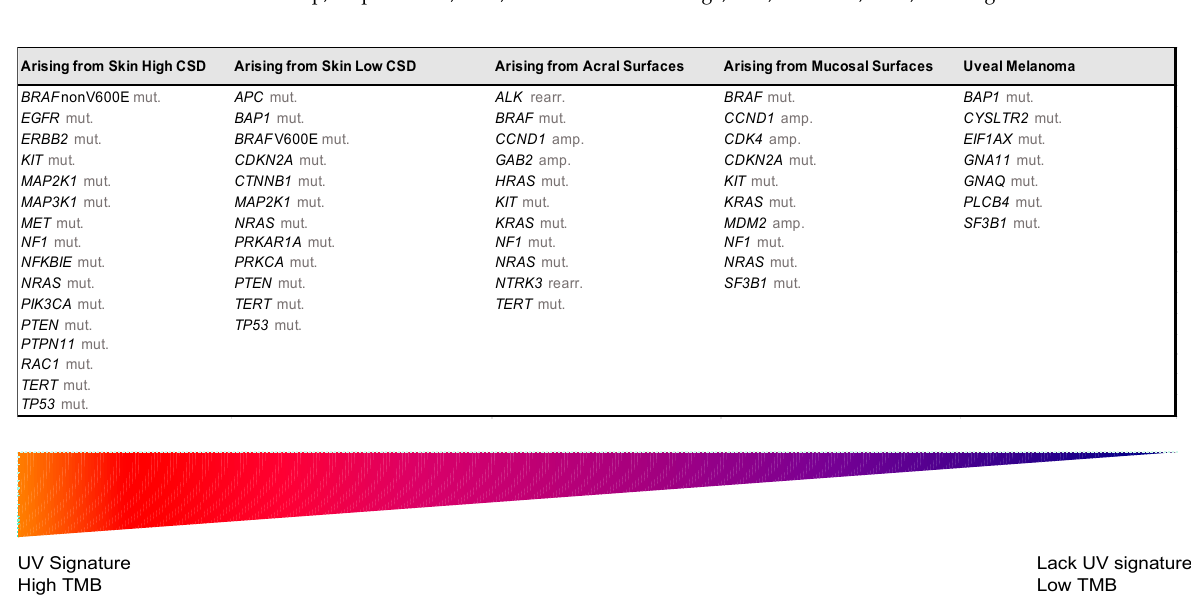
Figure 2. Genomic alterations of melanoma subtypes defined by UV exposure. Abbreviations: amp, amplification; CSD, cumulative sun damage; rearr, rearrangement; TMB, tumor mutational burden; UV, ultraviolet.